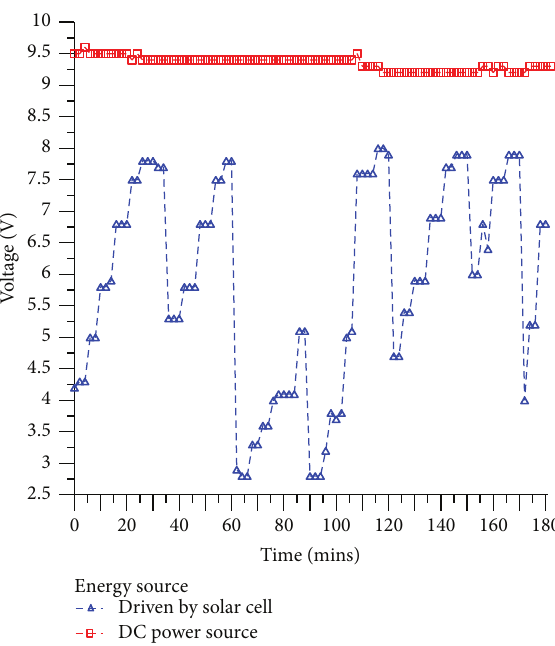
Figure 4: The electric voltages of thermoelectric system driven by DC source and solar